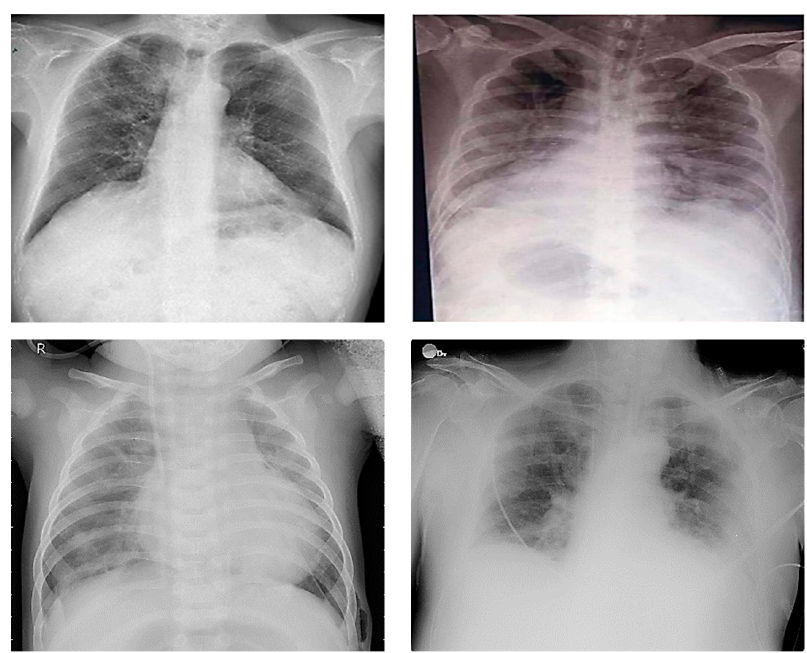
Figure 2. COVID-19-infected CXR samples used in the training of the CNN model [12–14].